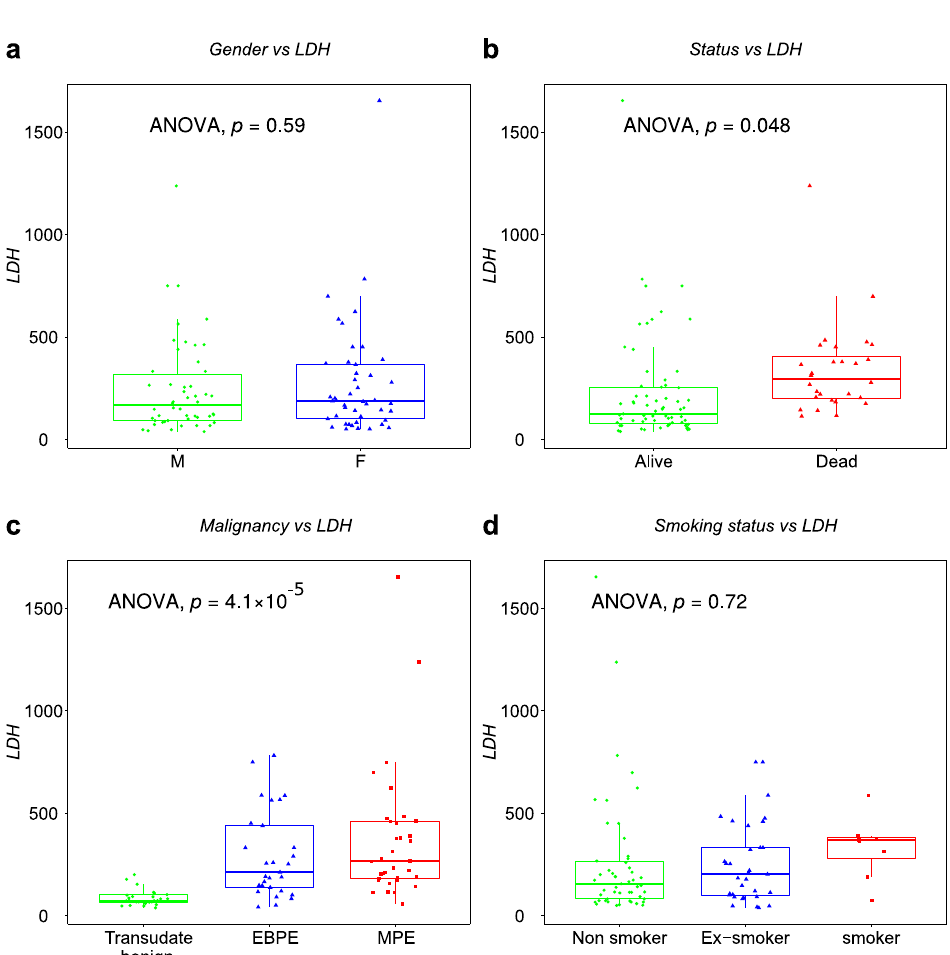
Figure A1. Boxplot of LDH as function ( a ) gender, ( b ) survival status, ( c ) malignant status and ( d ) smoking status.